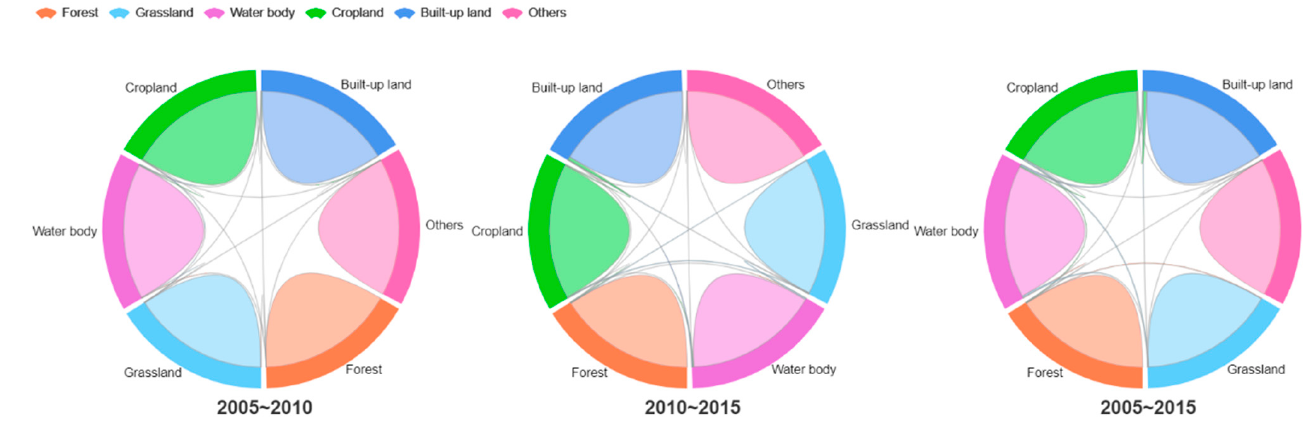
Figure 3. Ecosystem transfer in the Loess Plateau Ecological Screen.